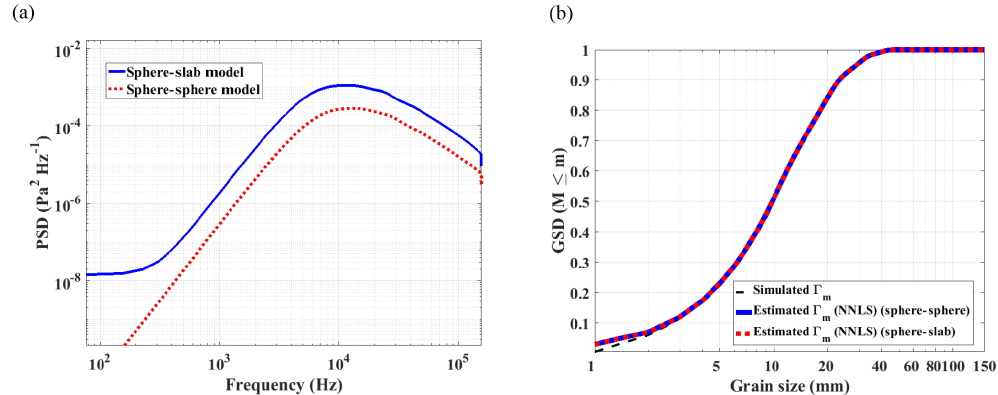
Figure 10. (a) Modeled spectra using a log-normal GSD, D = 1 , 2 ,..., 150mm, where D 84 = 2 D 50 , D 50 = 10mm (see medallion); typical input parameters are given in Table 1 and U imp = 1ms − 1 . Concerning the sphere–sphere impact, the impactor has the same size as the impactee; (b) inversion using the NNLS algorithm by acoustic spectra shown in (a)